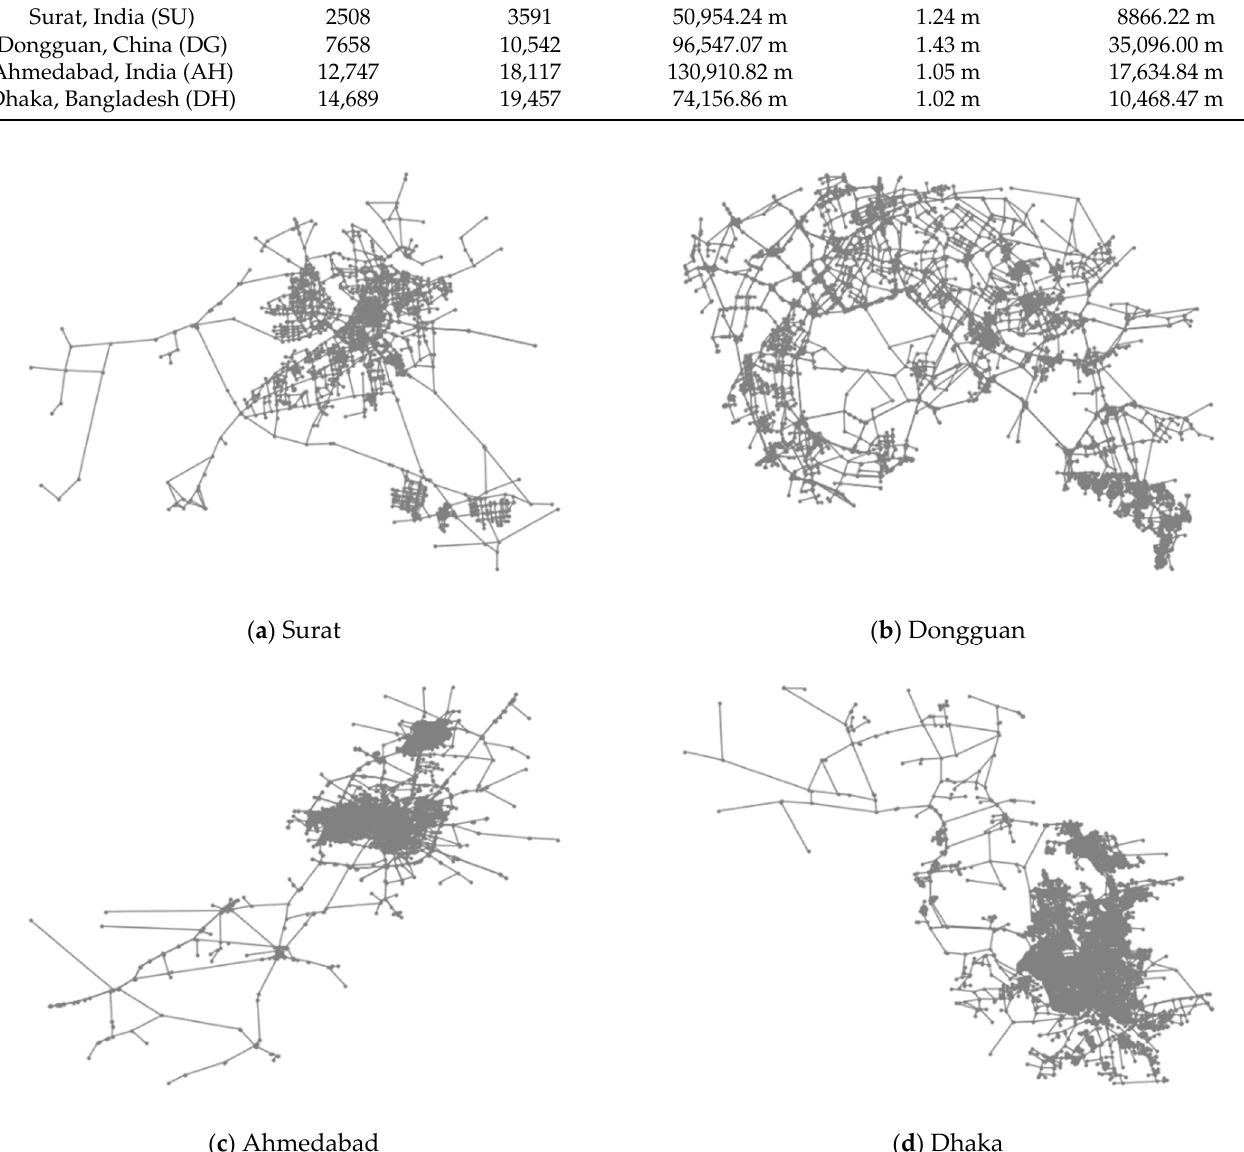
Figure 6. Road networks.